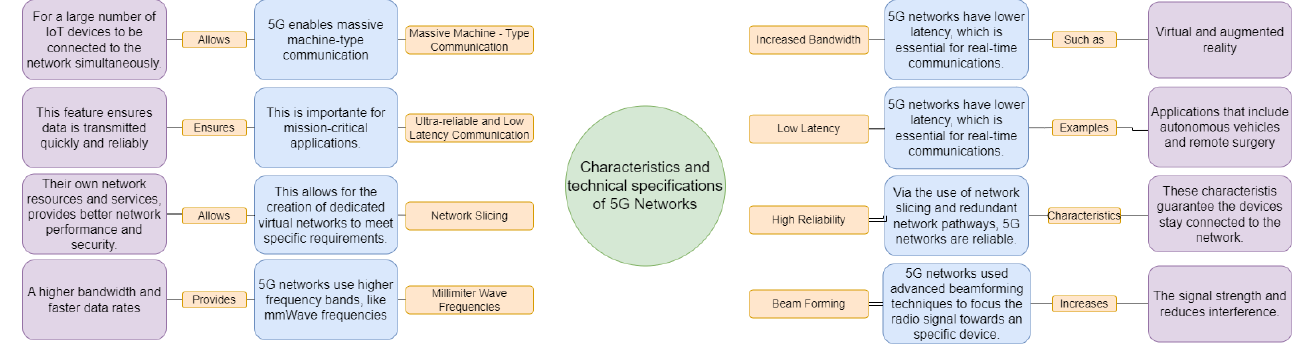
Figure 8. Characteristics and technical specifications of 5G